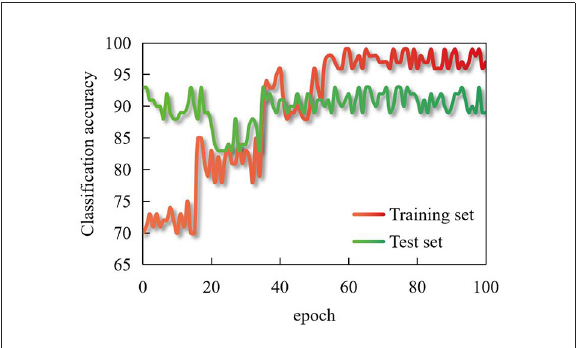
FIGURE6 Classification accuracy in training set and test set.